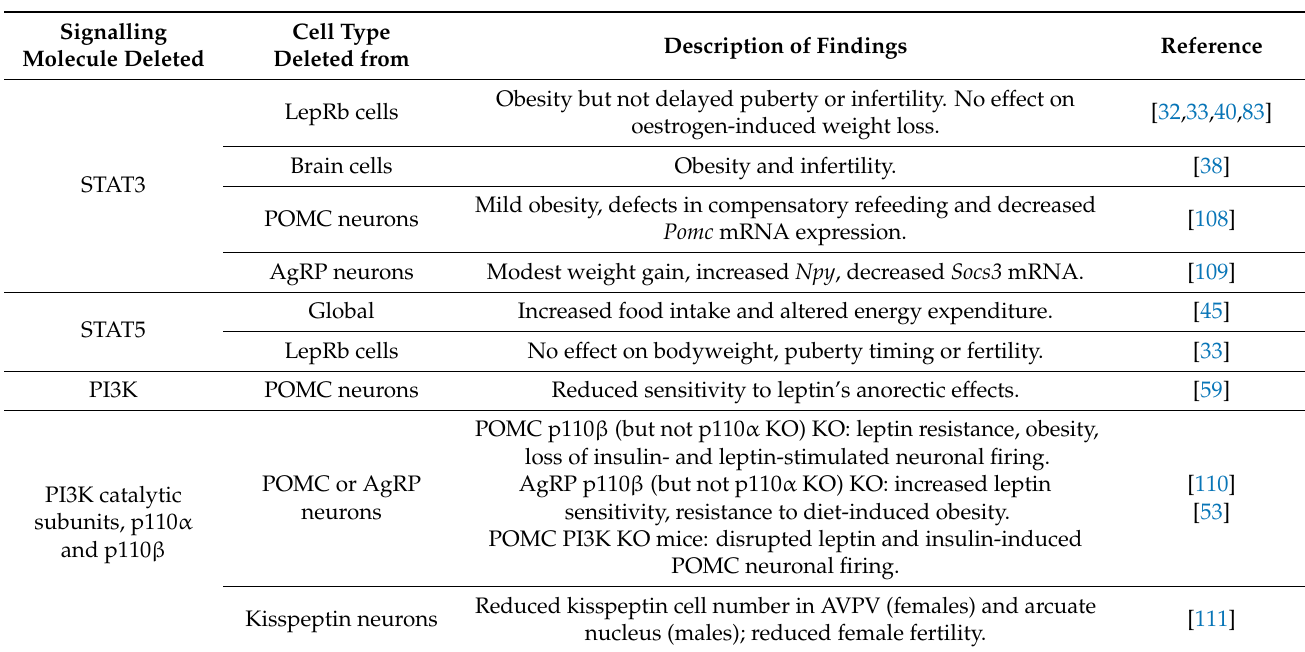
Table 1. Leptin signalling molecule knockout studies focusing on metabolic and reproductive function. See Figure 1 legend for abbreviations of signalling